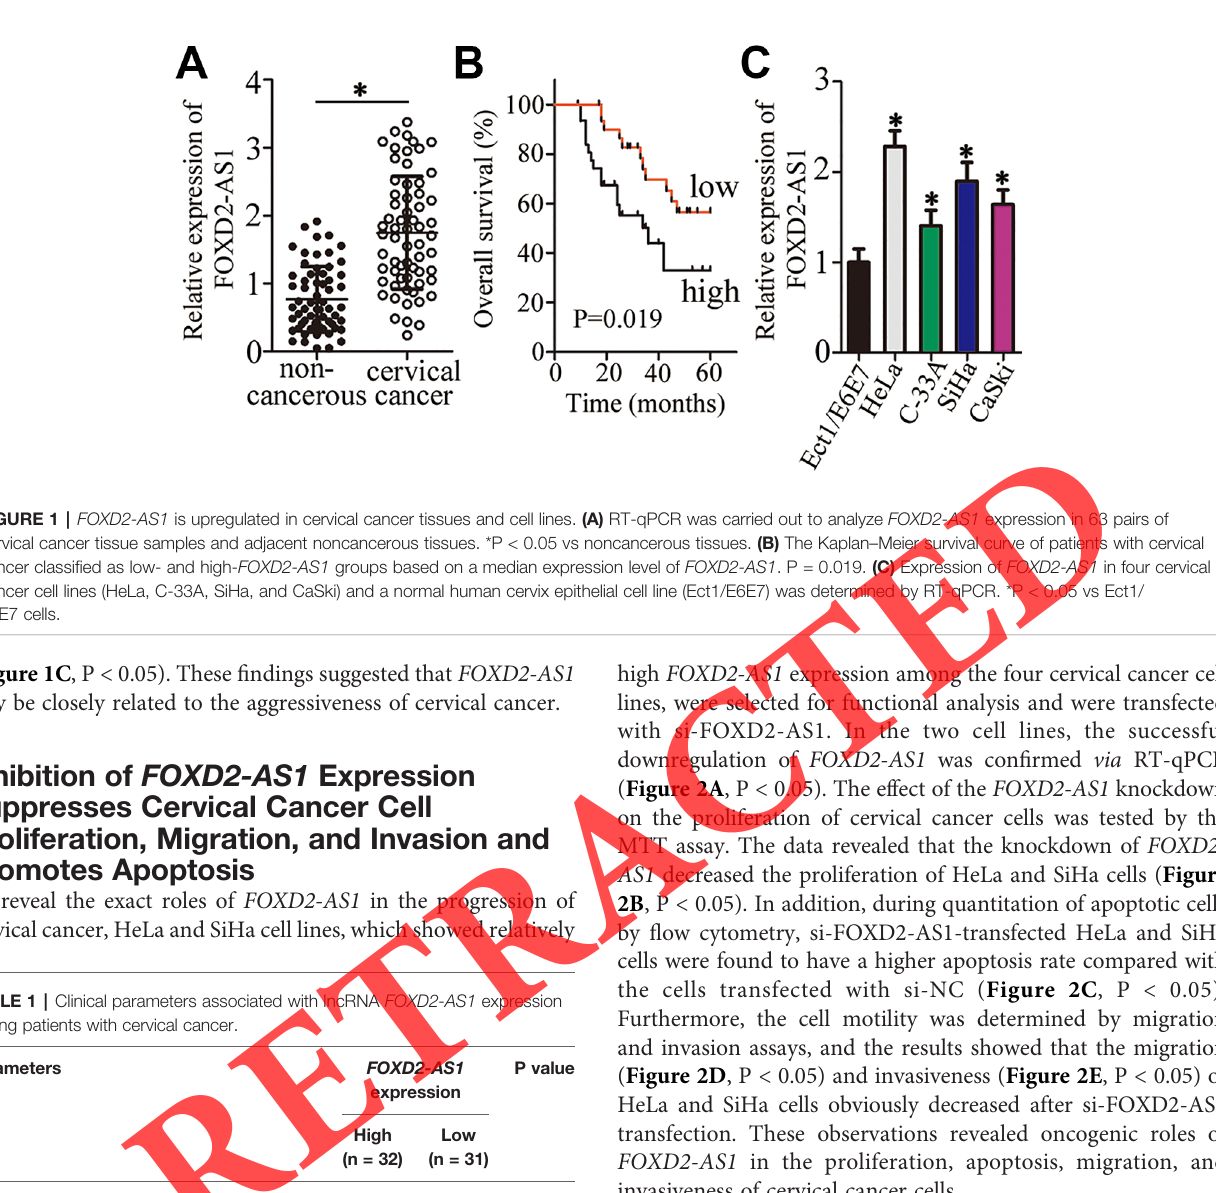
TABLE 1 | Clinical parameters associated with lncRNA FOXD2-AS1 expression among patients with cervical cancer. Parameters